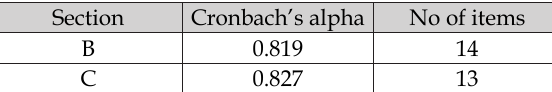
Table 2. Reliability